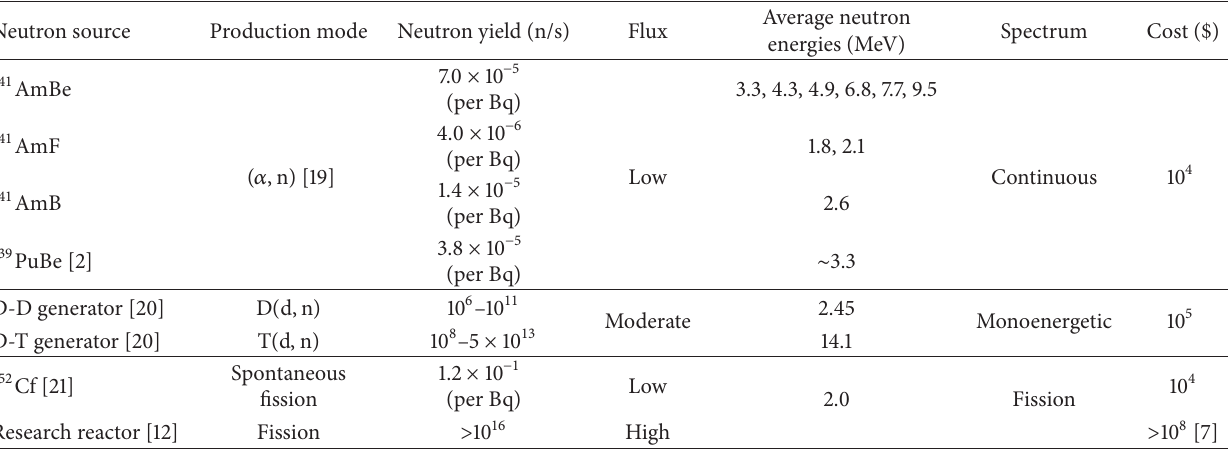
Table 1: Comparison of neutron sources.